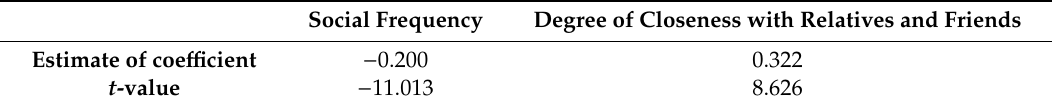
Table 7. Results of correlation analysis between social interaction and environmental